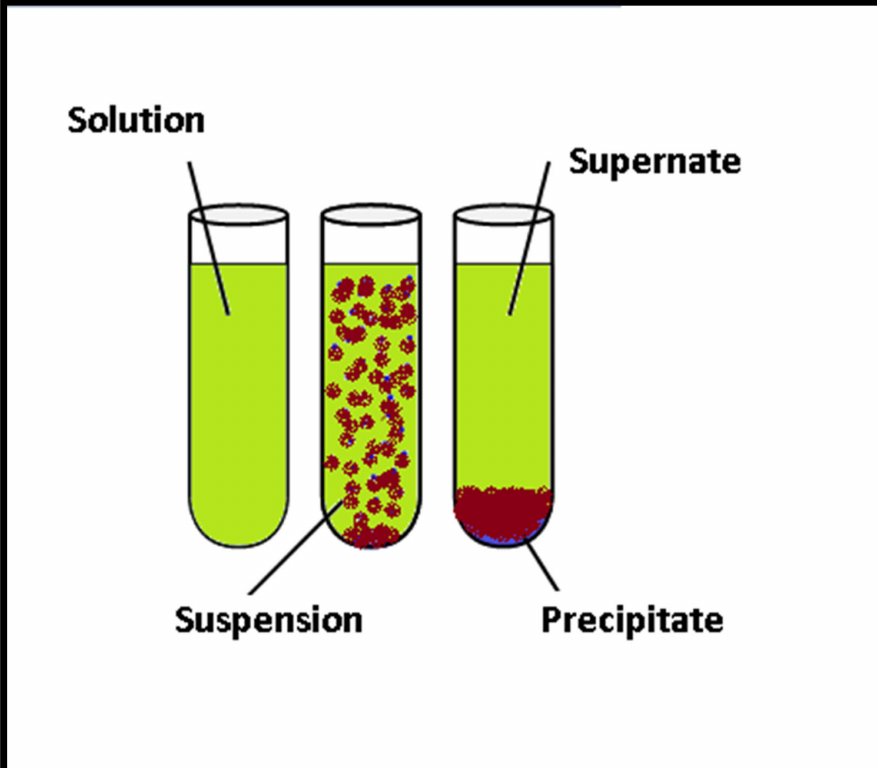
Figure 2. Precipitation reactions in wastewater